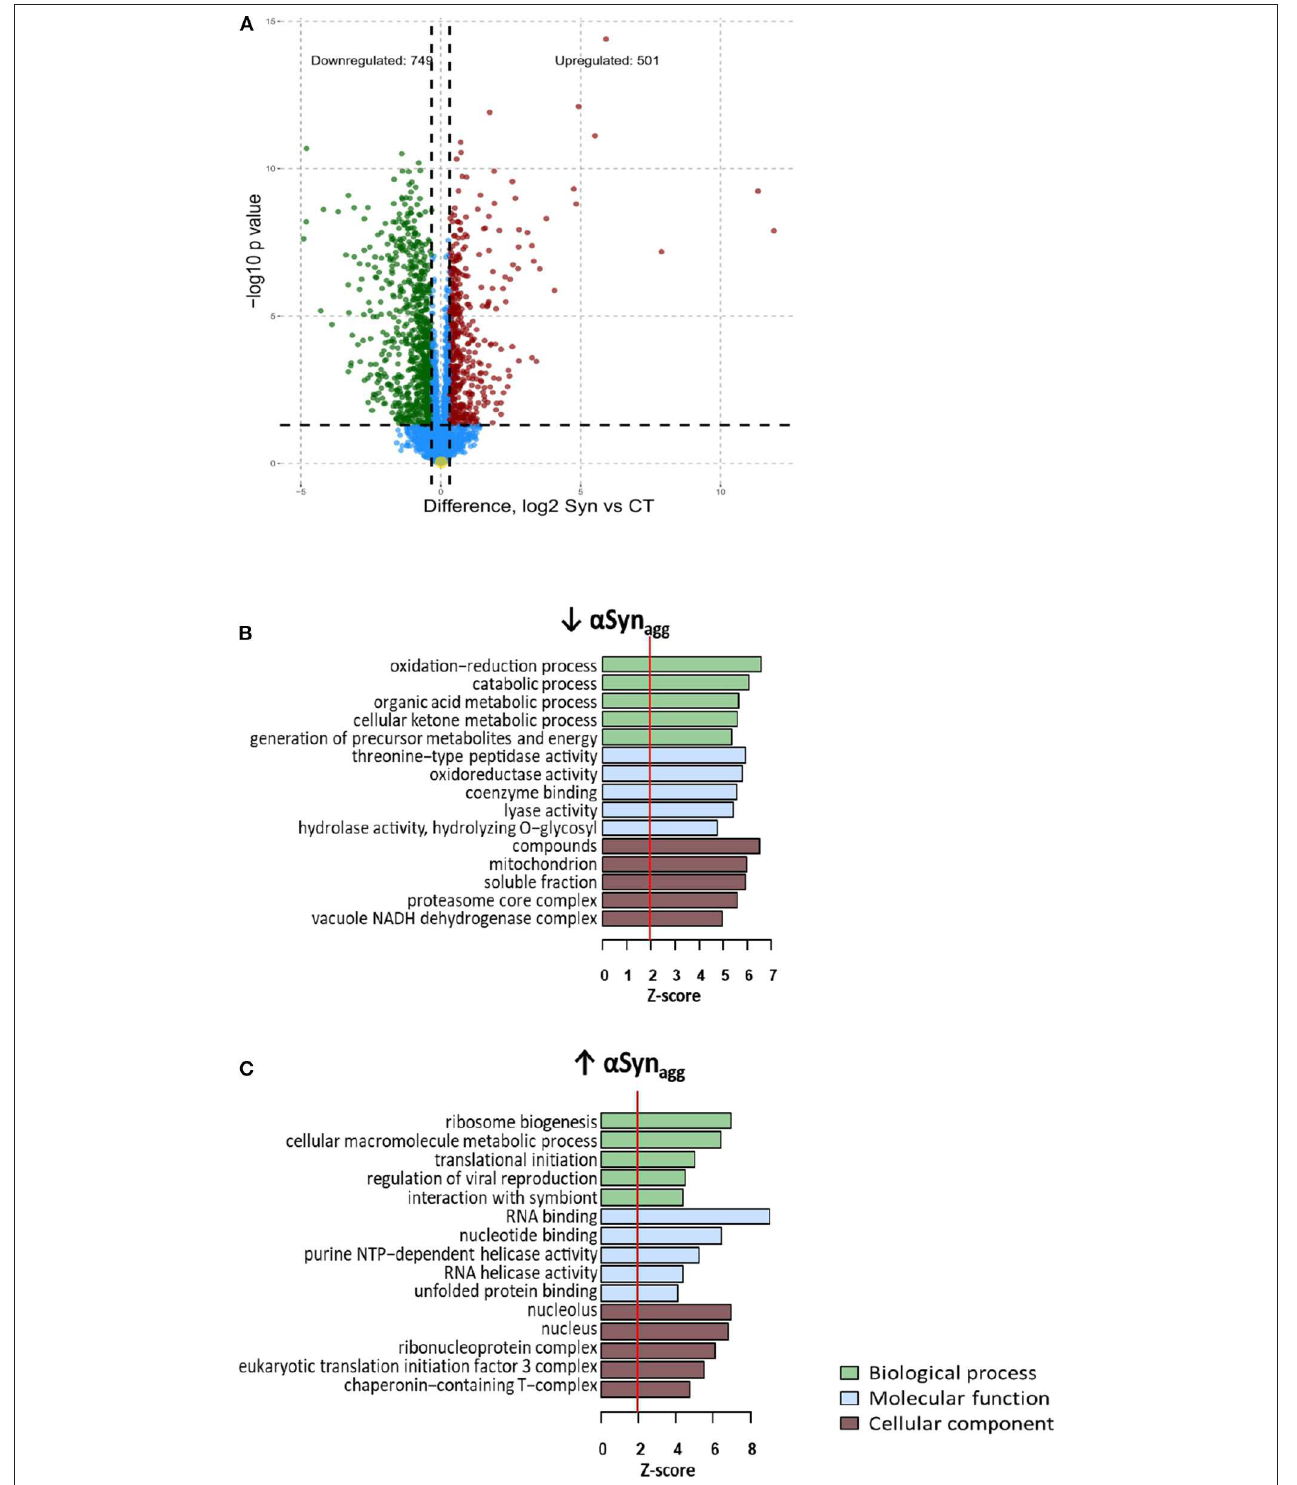
FIGURE 1 | Differential expression analysis of Synuclein-induced proteomic changes in microglia (A) Volcano plot: differential expression (Syn vs. Control) (B) Enrichment map: Gene ontology analysis of Syn-upregulated proteins (C) Enrichment map: Gene ontology analysis of Syn-downregulated proteins For b and c, Node color indicates direction of Syn-induced change in protein expression (Red: Upregulated, Blue: downregulated). Intensity of color of node represents level of significance (darker intensity indicates greater level of significance with white representing 0.05 significance level. Size of node indicates number of genes within the term (range 5–300). Edges connecting nodes are thinnest at a similarity score of 0.4 and max thickness at similarity max 1.